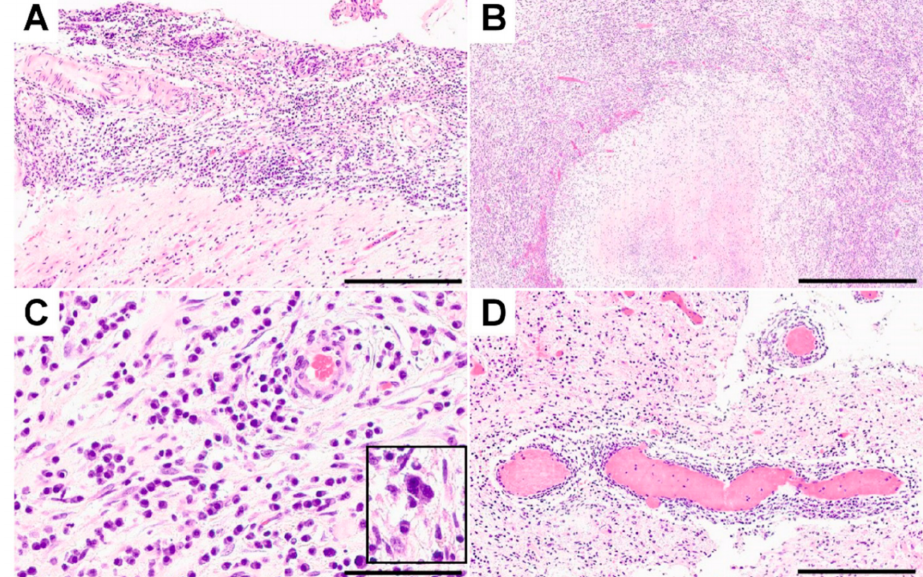
Figure 2. Fibrotic leptomeninges (( A ) scale bar: 300 µ m) and gliotic brain parenchyma (( B ) scale bar: 500 µ m) were observed, accompanied by foci of necrosis surrounded by densely packed inflammatory infiltrates comprised of lymphocytes, plasma cells, granulocytes, histiocytes, fibroblasts (( C ) scale bar: 50 µ m), and solitary multinucleated giant cells (inset in C ). Leptomeningeal and intraparenchymal blood vessels showed perivascular inflammation without signs of vasculitis (( D ) scale bar: 300 µ